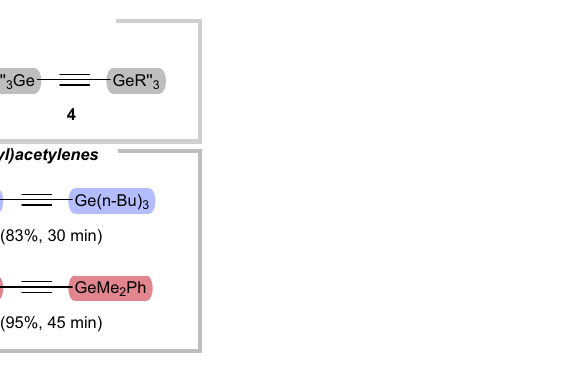
Figure 3. Substrate scope for C–germylation of